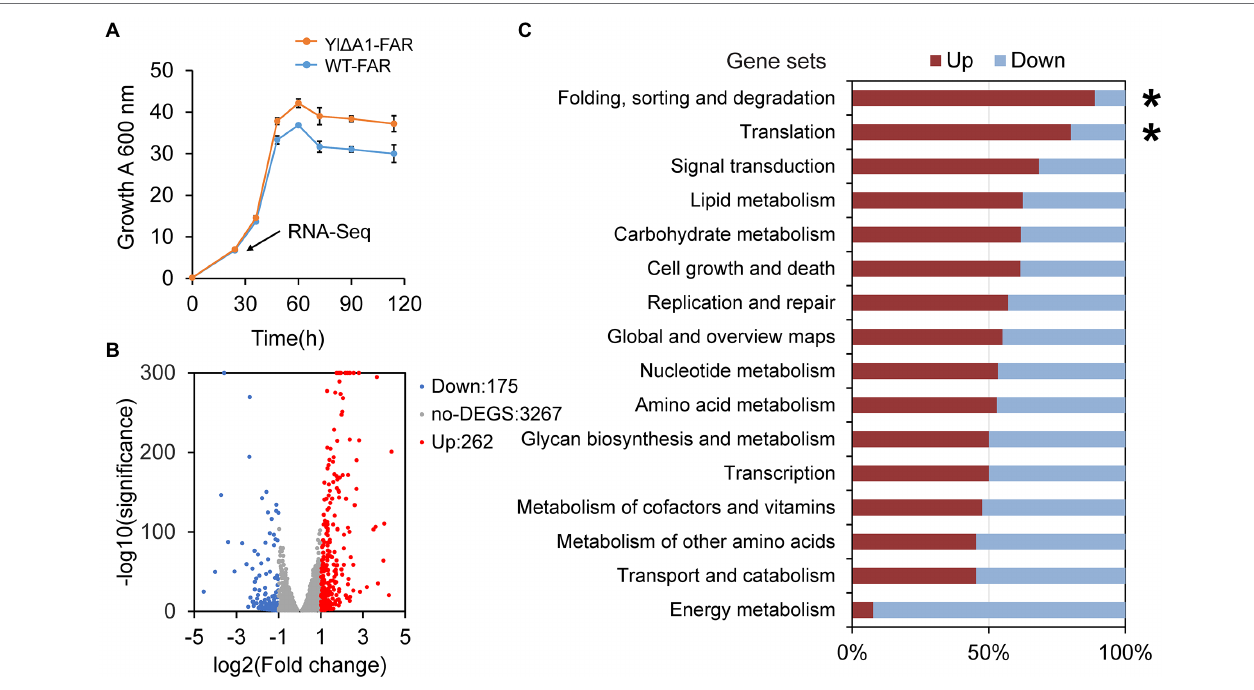
FIGURE 4 | Transcriptome analysis of Yl Δ A1-FAR and WT-FAR. (A) Growth rate of Yl Δ A1-FAR strain with high fatty alcohols production compared with WT-FAR under rich medium conditions. All cultivations were performed in rich YPD medium for 108 h. Transcriptome analysis (RNA-Seq) was performed on the samples at 24 h (pointed by arrow). Results are presented as mean ± s. d. of three biological replicates. (B) Fold changes (log2) of genes differentially expressed (adjusted p < 0.05, |Fold change| > 1) in Yl Δ A1-FAR cells relative to WT-FAR cells. Genes at the positive side of the x axis are upregulated (highlighted in red), and genes at the negative side are downregulated (highlighted in blue). (C) KEGG pathways enrichment analysis. Gene sets were defined by KEGG pathways, which showed the percentage of genes that were either up- (red) or down-regulated